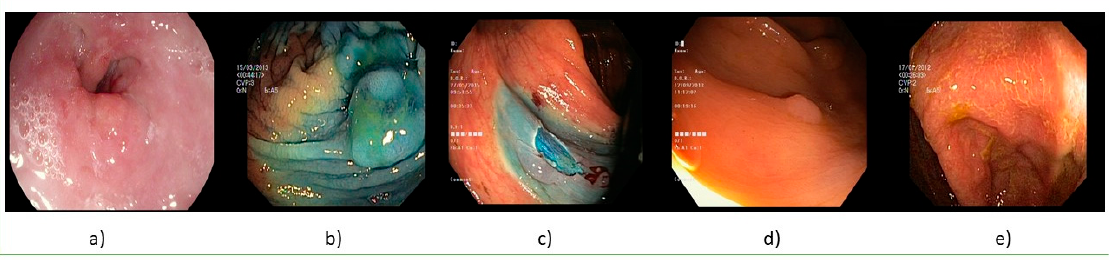
Figure 2. Abnormal images: ( a ) esophagitis, ( b ) dyed, and lifter polyps, ( c ) dyed dissection margins, ( d ) polyps, and ( e ) ulcerative